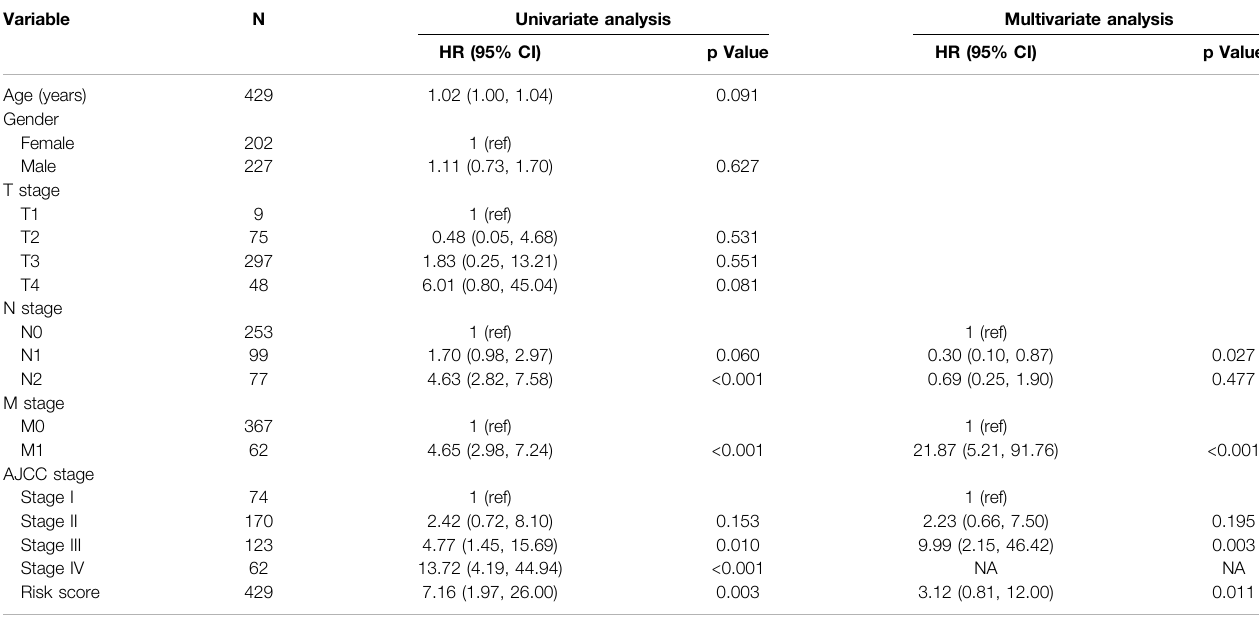
TABLE 2 | Univariate and multivariate analyses in TCGA-COAD cohort.